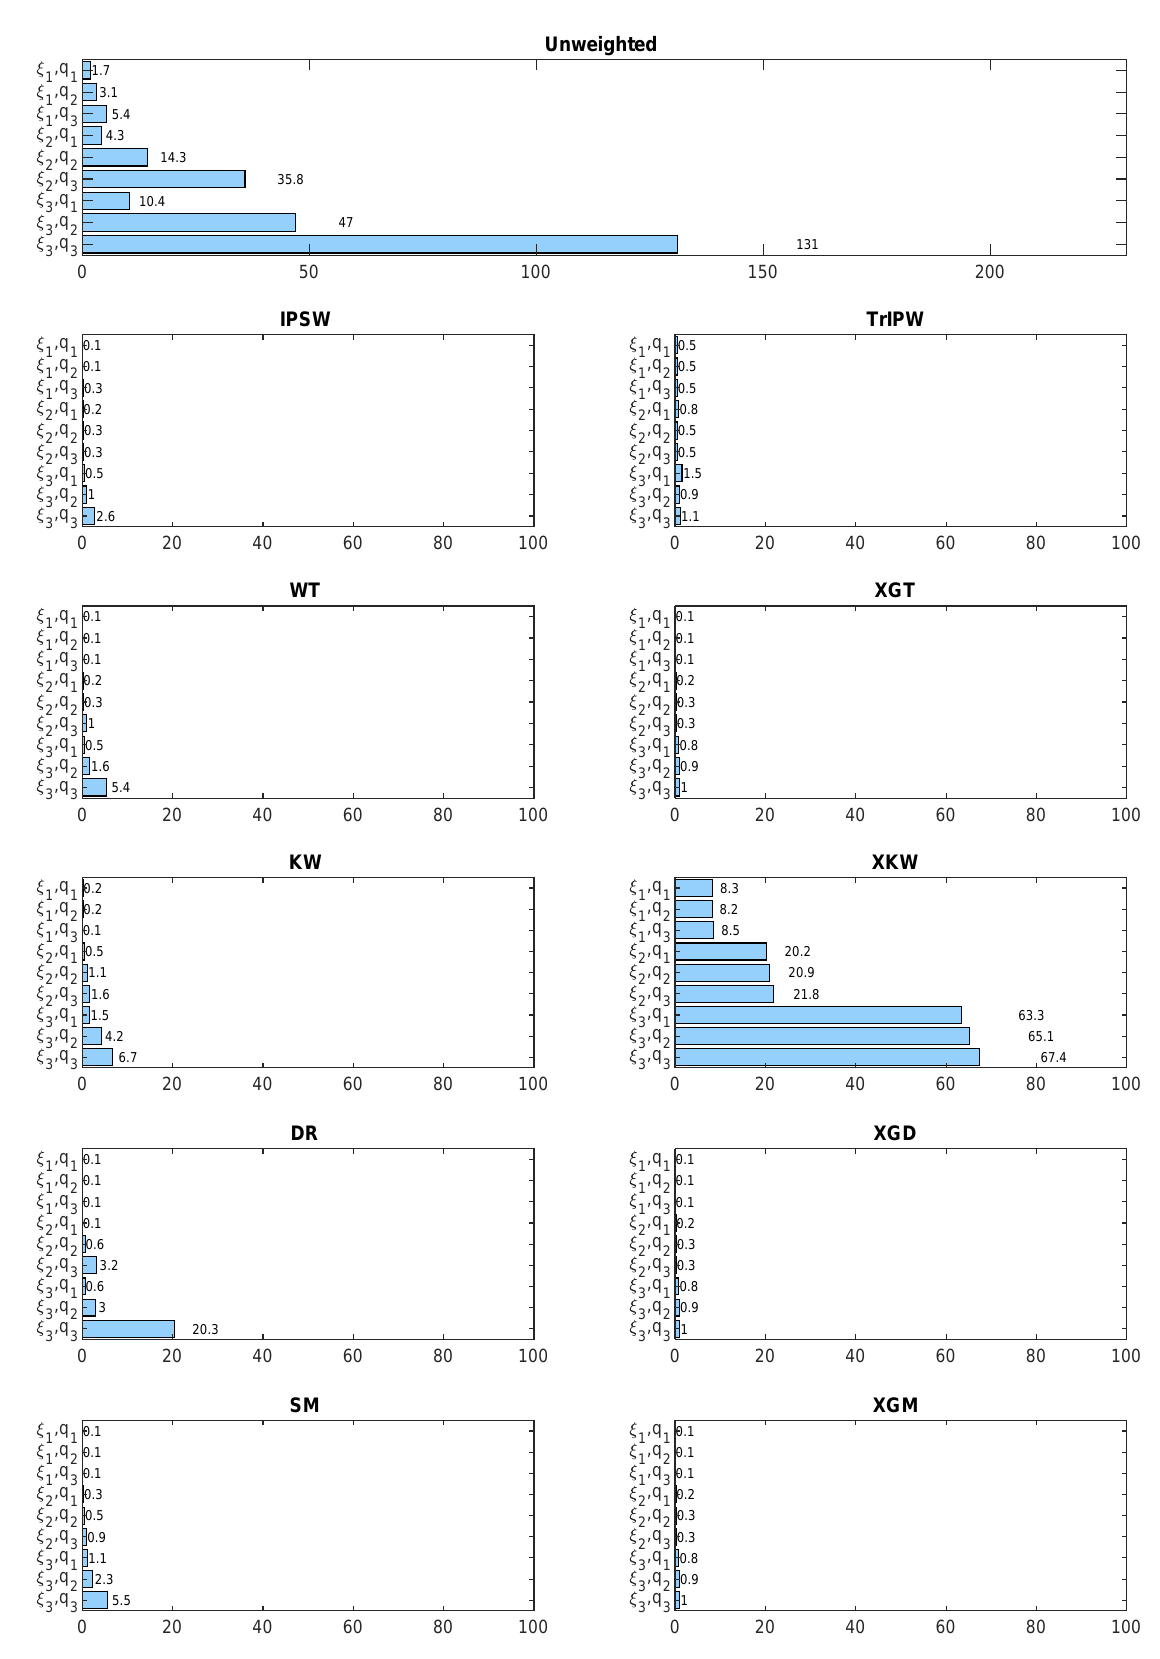
Figure 2. MSE, simulated case, correlation coefficient: